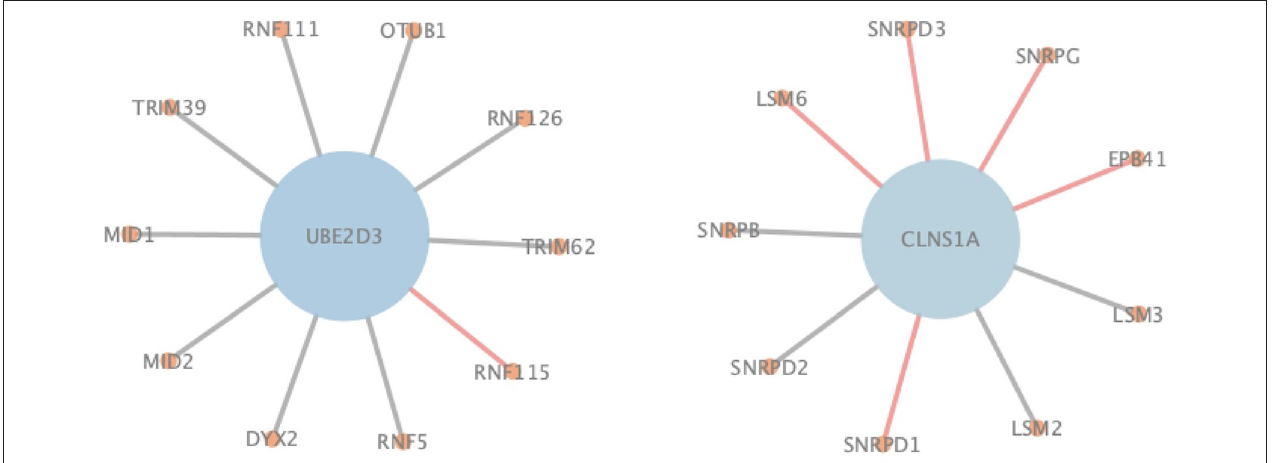
FIGURE 6 | An illustration of PPIs correctly identified by NGPM in the Human dataset.